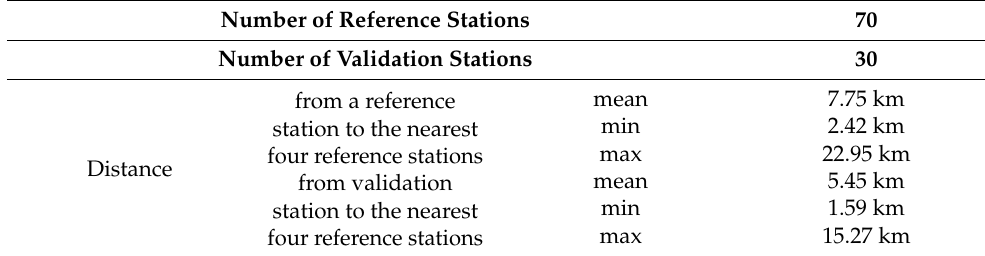
Table 1. Characteristics of PM monitoring stations used in